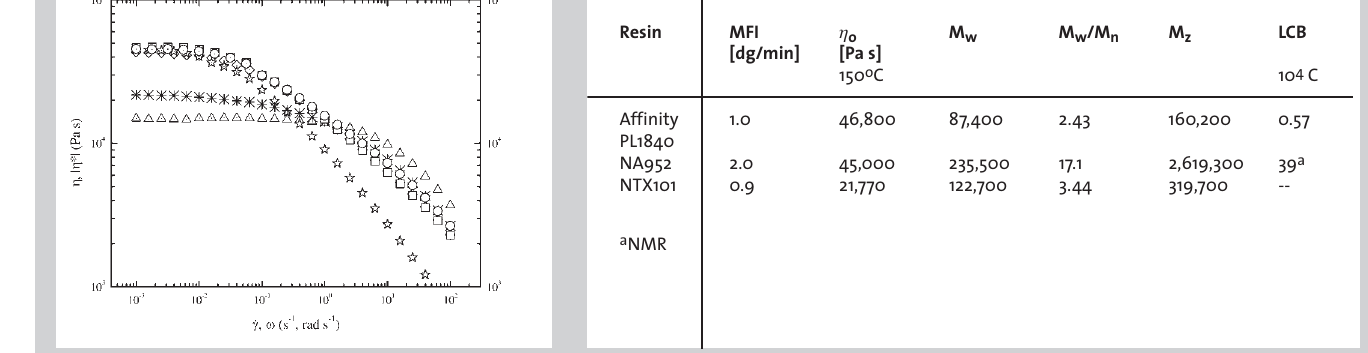
Table 1: Molecular features of three